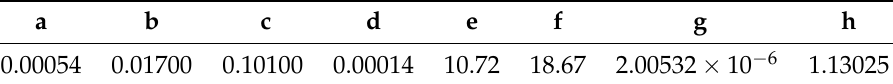
Table 1. The first Heligman–Pollard law: parameters.